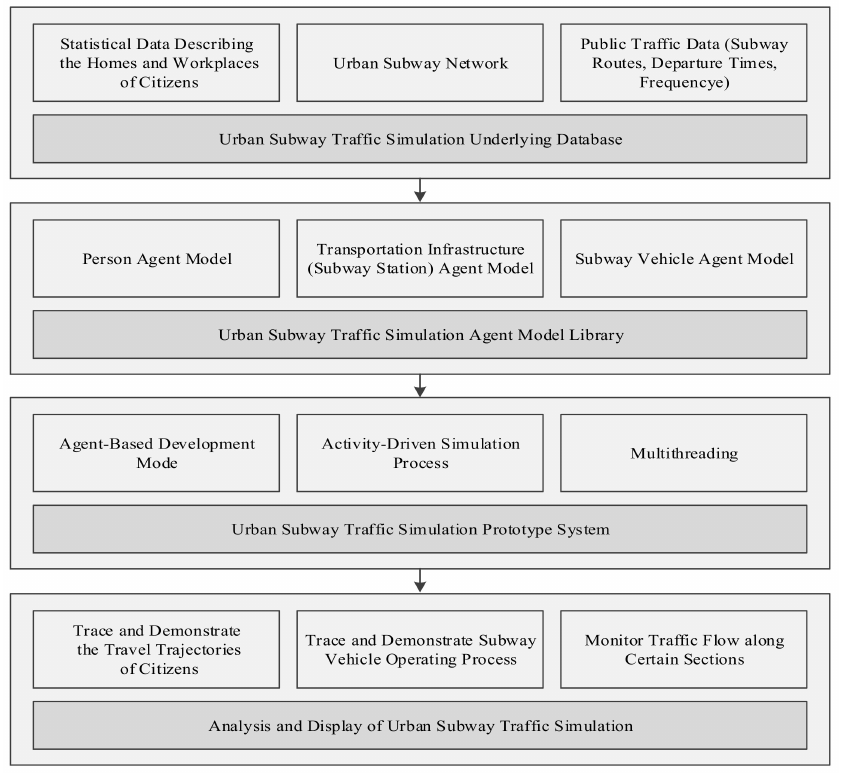
Figure 1. Tra ffi c simulation framework architecture